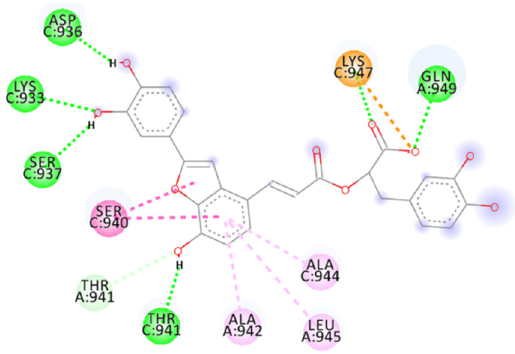
Int. J. Mol. Sci. 2022 , 23 , 10067 Figure 11. Calculated 2D interactions of Sal C in complex with SARS-CoV-2’s HR1 domain.